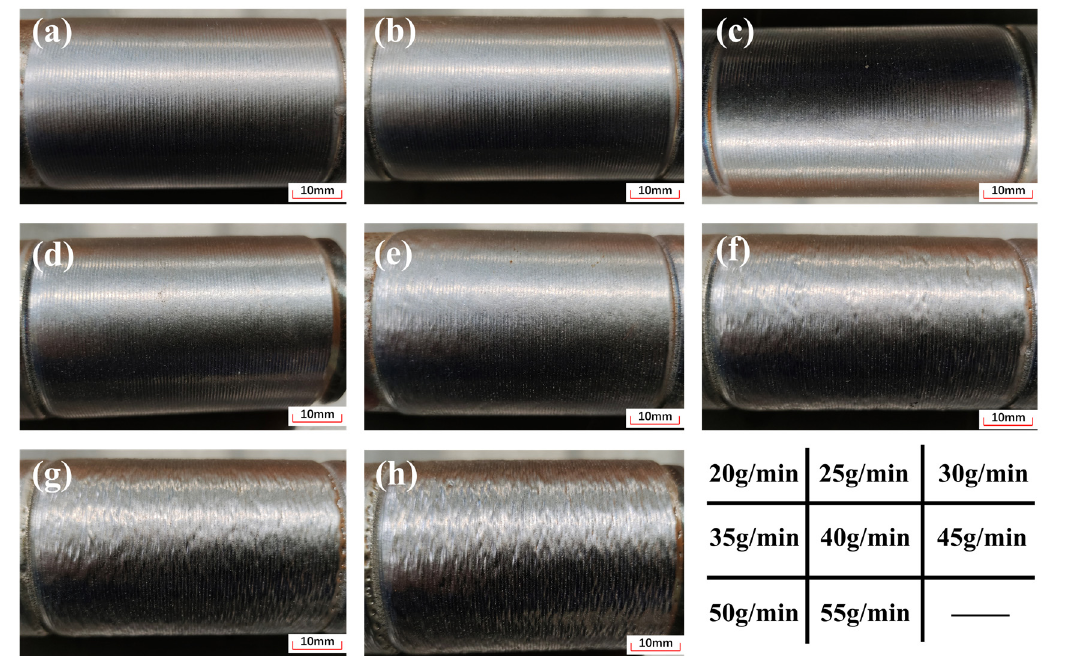
Figure 18. Macro-morphologies of EHLA coatings under di ff erent powder feeding speeds. ( a ) 20 g/min; ( b ) 25 g/min; ( c ) 30 g/min; ( d ) 35 g/min; ( e ) 40 g/min; ( f ) 45 g/min; ( g ) 50 g/min; ( h ) 55 g/min.